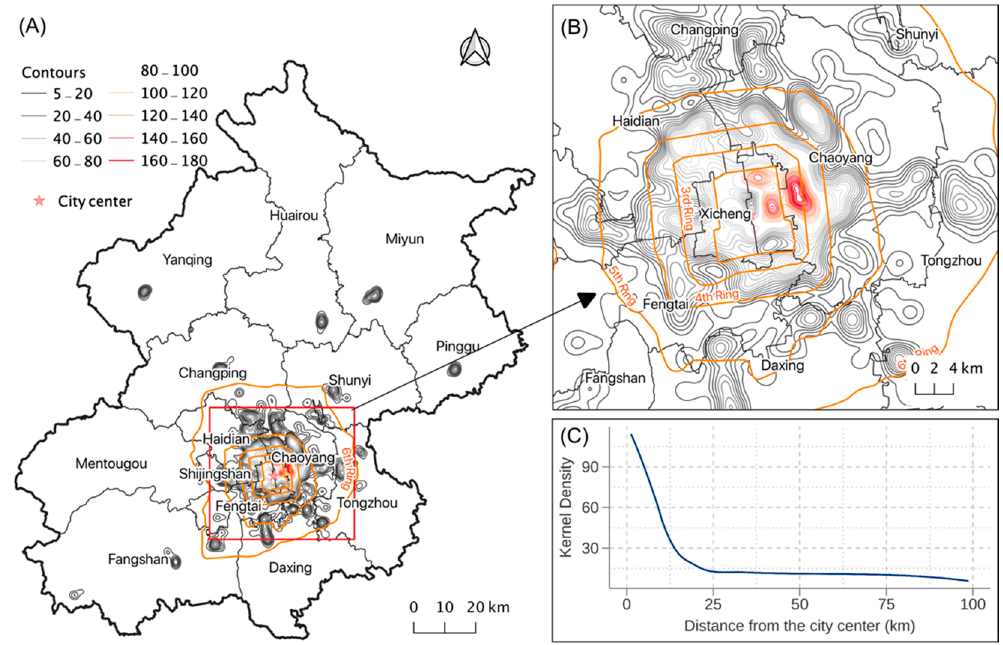
Figure 8. Spatial distribution of the kernel density contour of the accommodation and catering industry in Beijing. ( A ) Distribution in Beijing; ( B ) Distribution within the Fifth Ring Road; ( C ) Relationship between the kernel density distribution distance and the distance to the urban center.